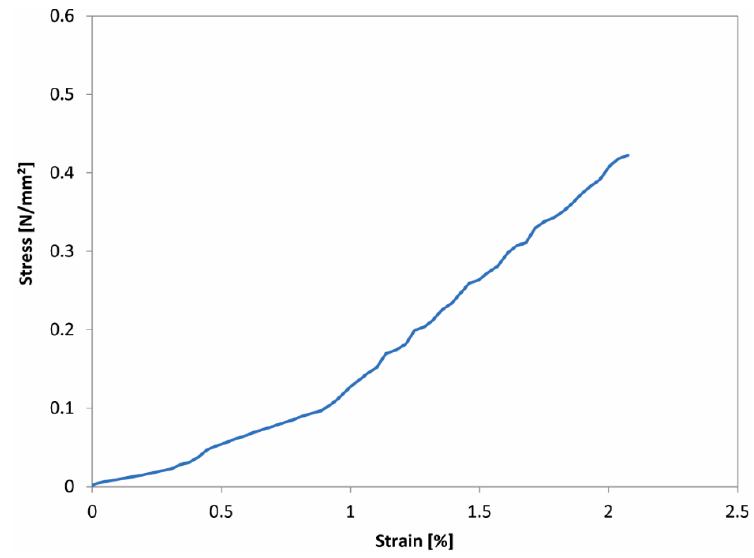
Figure 7. Stress–strain curve of the final material.